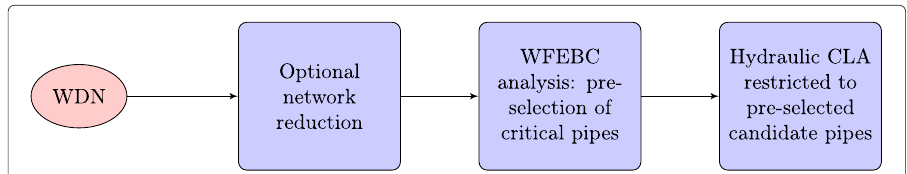
Fig. 11 Hybrid critical link analysis. The flowchart illustrates a hybrid methodology for critical link analysis: following an optional network reduction step, a restricted set of critical pipes is pre-selected based on their WFEBC values for further hydraulic analysis (i.e. implementing reserve capacity). This is made possible by the relation between WFEBC and reserve capacity values (see Figure